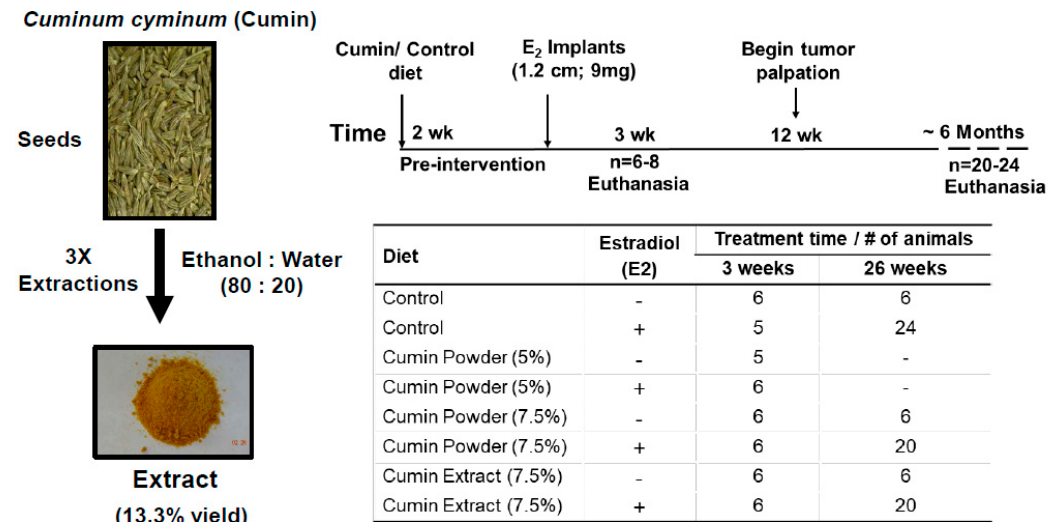
Figure 8. Ground Cuminum cyminum (cumin) seeds powder and derived dried ethanolic extract was used in this study. Schematic representation of animal study plan; table shows the animal study design used in the study.